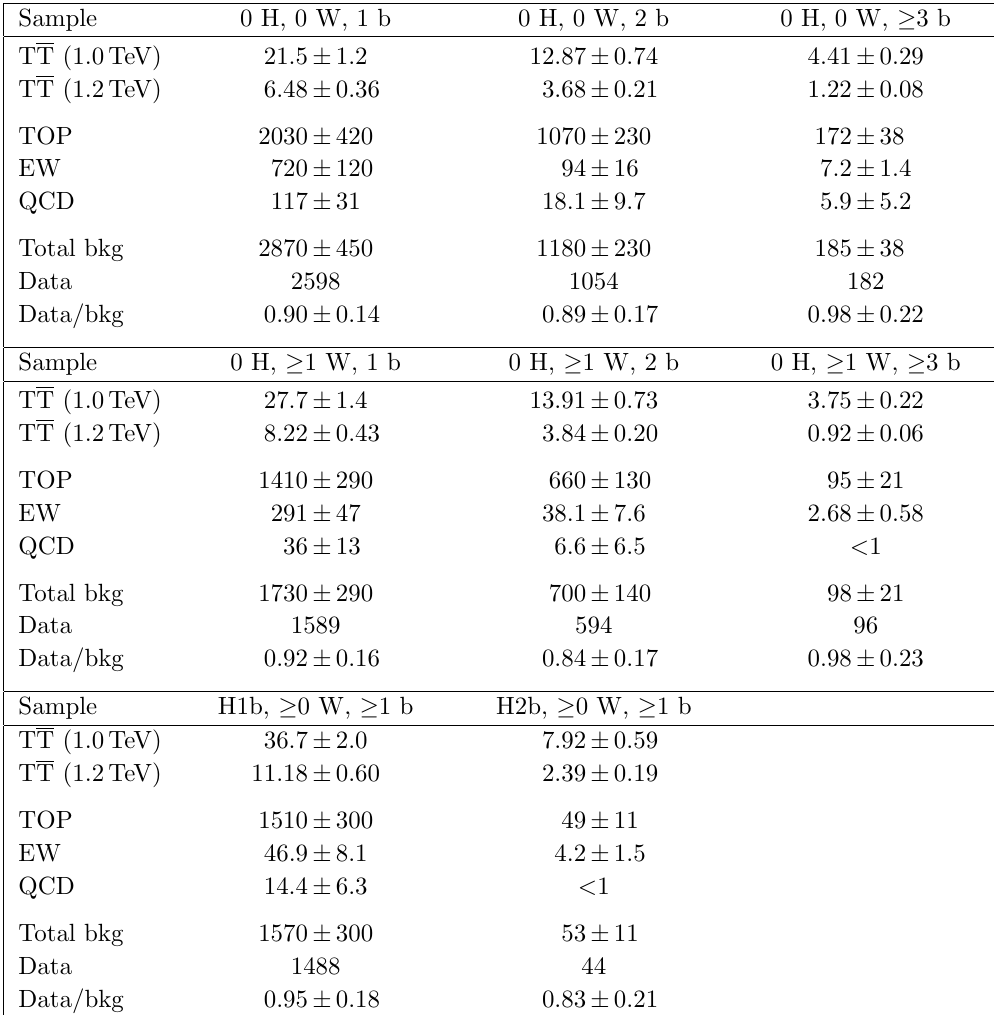
Table 5 . Numbers of predicted and observed events for signal region categories of the single-lepton channel before the (cid:12)t to data. Uncertainties include both statistical and systematic components.